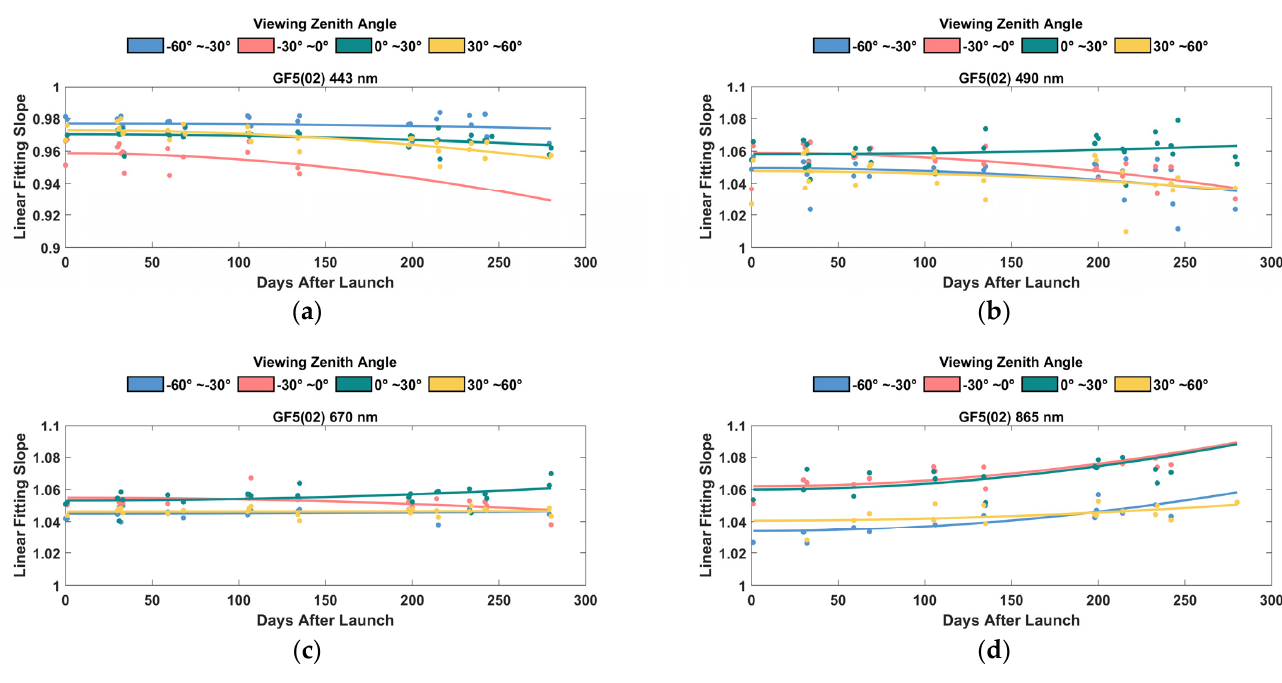
Figure 7. The linear fitting slope and corresponding quadratic fitting curve of DPC and POSP normalized radiance in common spectral bands with different post-launch days and different VZA ranges. The data pairs are collected in each day selected from October 2021 to July 2022 of ( a ) 443 nm; ( b ) 490 nm; ( c ) 670 nm; and ( d ) 865 nm bands in DPC and POSP Level 1 products.